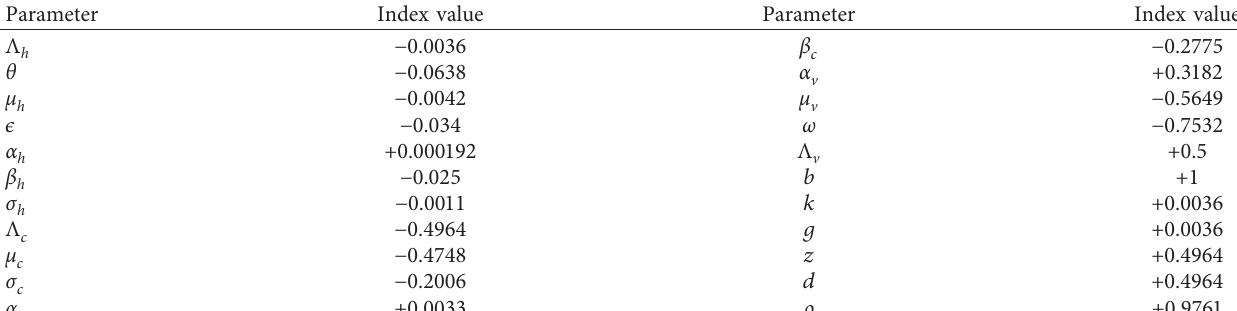
Table 3: Sensitivity indices of R e using parameter values in Table 4.